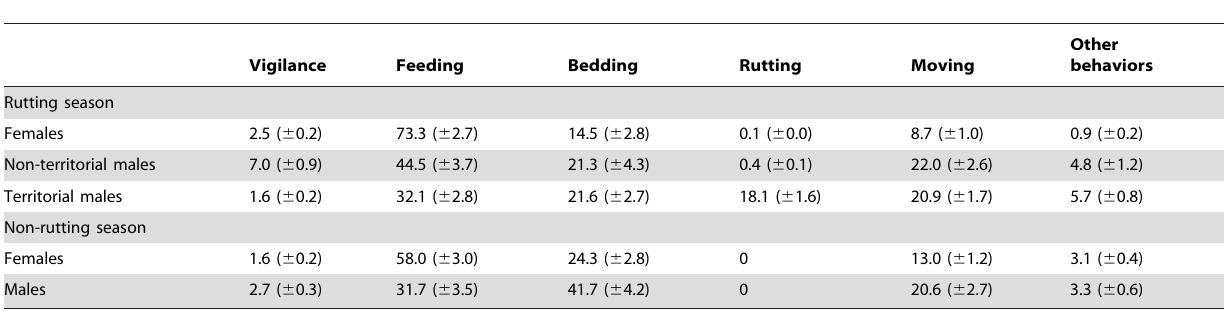
Table 2. Breakdown of time spent (%) in different activities in different categories of Przewalski’s gazelle.